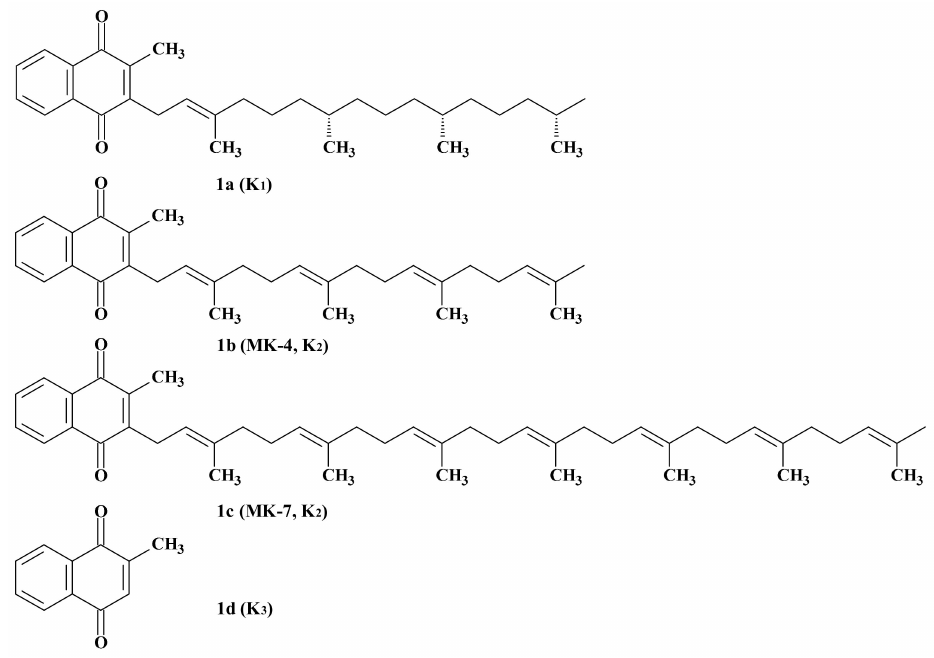
Figure 1. Chemical structures of vitamin K ( 1 ). ( 1a ) K 1 ; ( 1b and 1c ) K 2 ; and ( 1d ) K 3 .